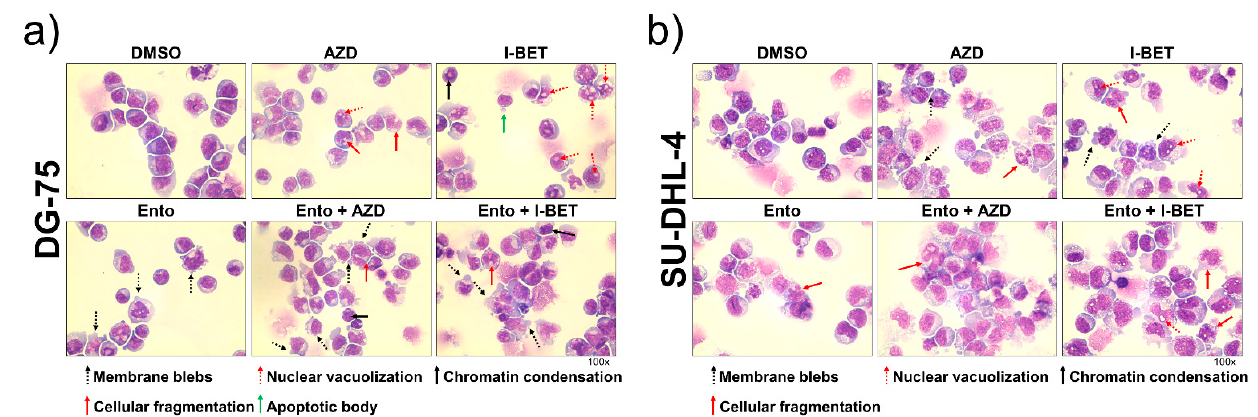
Figure 3. Morphological characterization after BET and SYK inhibition. Cells were exposed to 1 µM Ento, 0.01 µM AZD or 0.1 µM I-BET as a single agent or in combination. Representative light microscopy images of exposed cells after 72 h incubation. Cytospins were stained with May–Grunwald Giemsa stain (Pappenheim method). Light microscopy images (×100) revealed only moderate morphological changes in ( a ) BL cell line DG-75 and ( b ) DLBCL cell line SU-DHL-4.